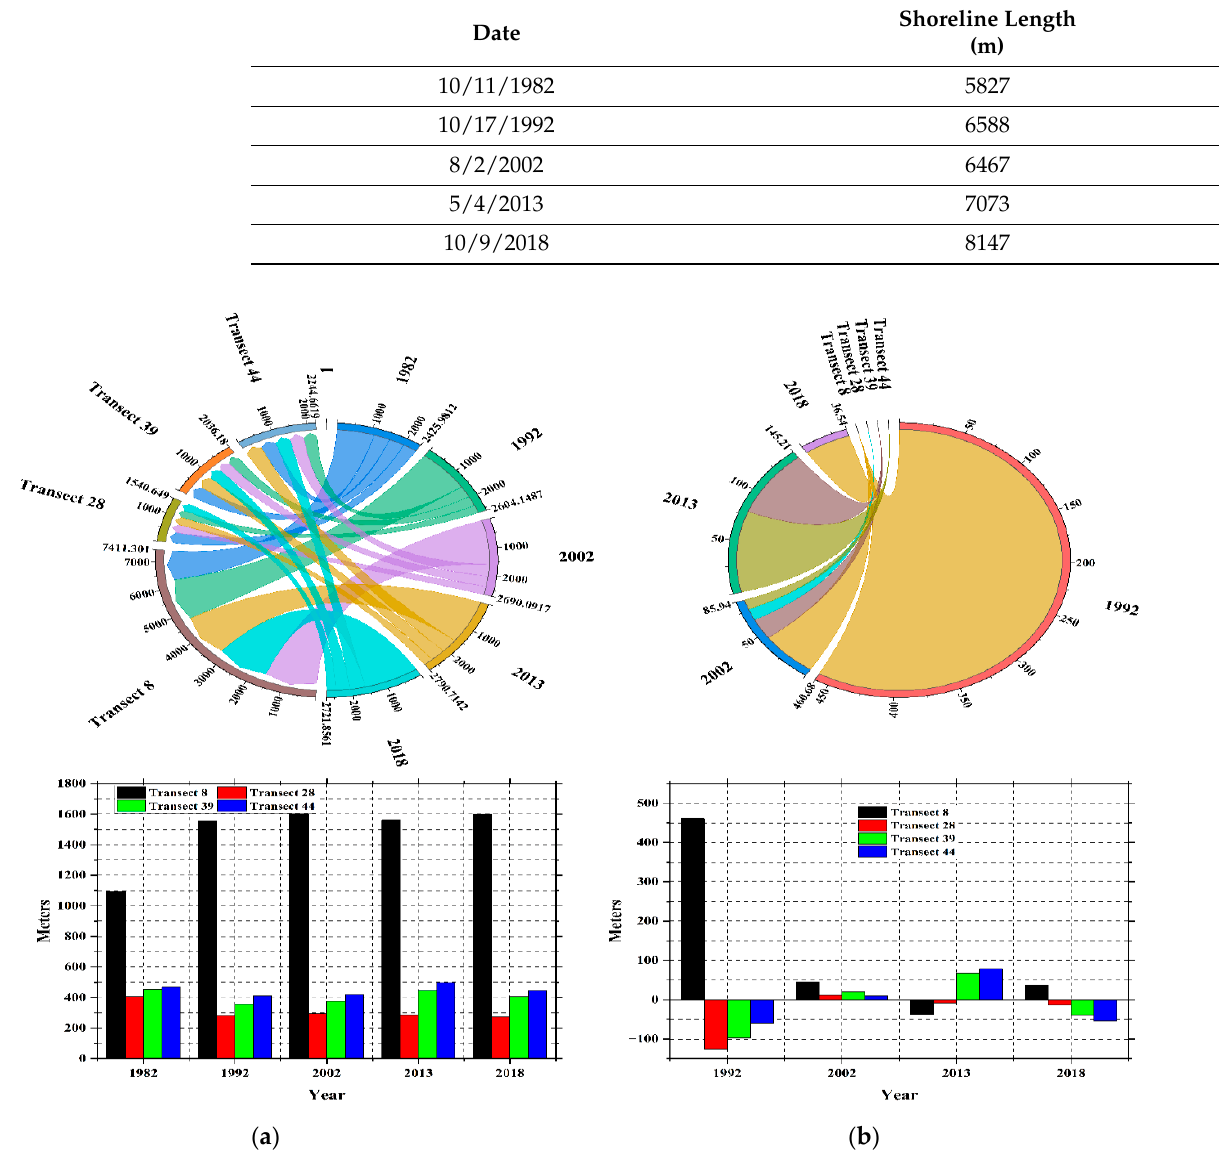
Figure 19. ( a ) Distance from baseline (m), ( b ) shoreline gain/loss in comparison to the last timeline (m).